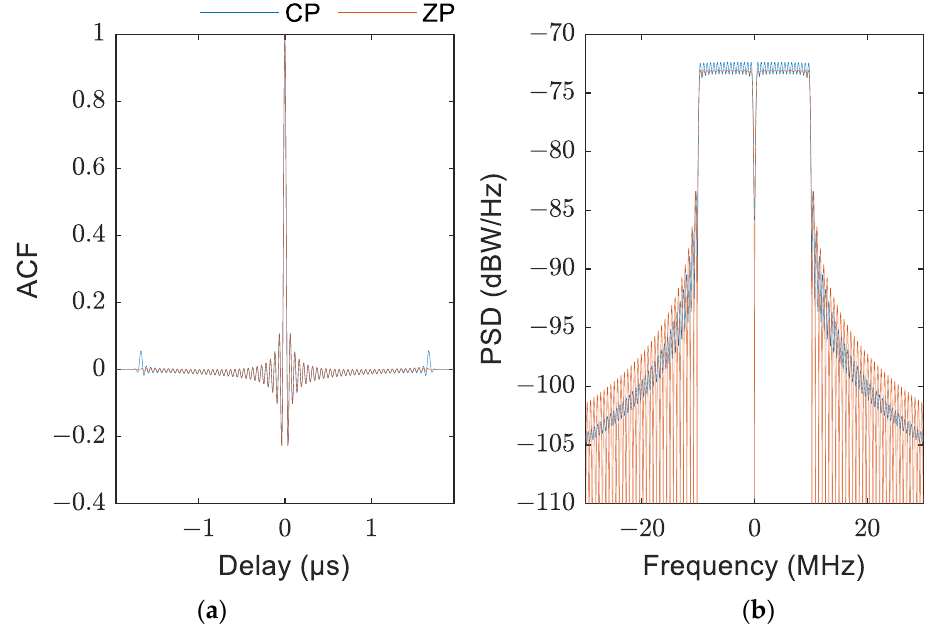
Figure 7. Effect of guard interval type on the ACF and PSD. ( a ) The ACF of the OFDM navigation signals with different guard interval types; ( b ) The PSD of the OFDM navigation signals with different guard intervals.